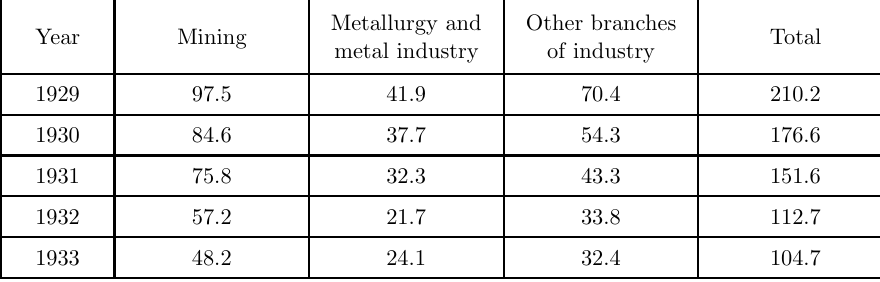
Employment in the Upper Silesian industry in 1929–1933 (in thousand people) Metallurgy and Other branches Year Mining Total metal industry of